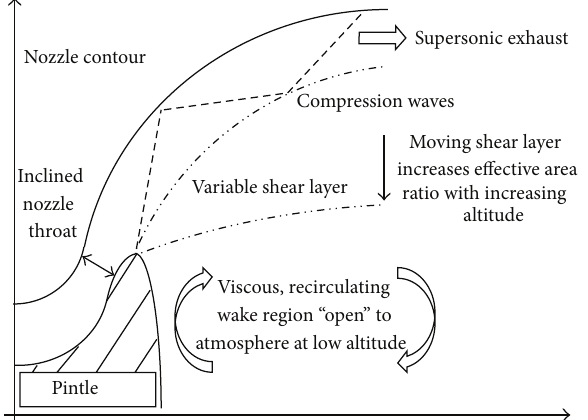
Figure 1: Half diametric cross section of the expansion-deflection nozzle behavior in open mode.